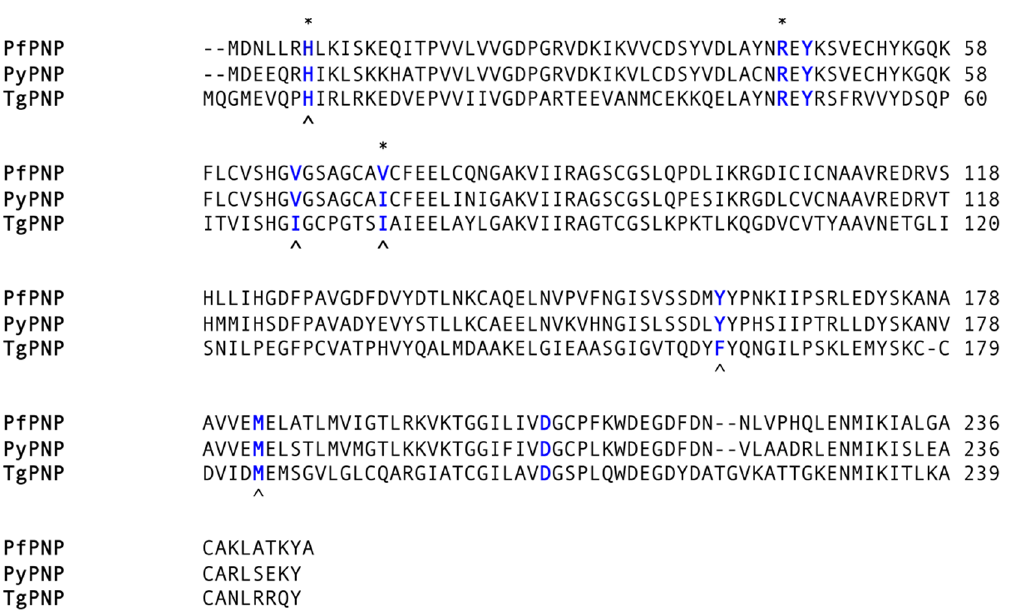
Figure 3. Alignment of apicomplexan PNPs. ClustalW alignment of PNP protein sequences from T. gondii (TgPNP), P.yoelli (PyPNP), and P. falciparium PNP (PfPNP). Residues involved in substrate binding are highlighted [38]. Residues in blue font indicate those surrounding the catalytic domain that were mutated in this study. Amino acids marked: (*) are from the adjacent subunit, ( ‘ ) residues are associated with the hydrophobic cavity for accepting the 5 9 -Methylthio group of